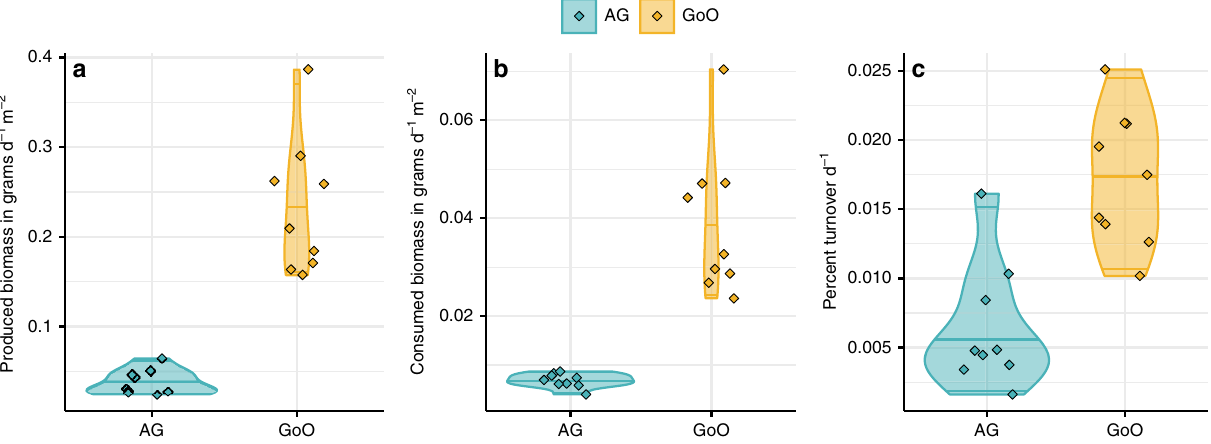
Fig. 6 Estimated biomass production, consumption, and turnover in cryptobenthic fi sh assemblages in the Arabian Gulf (AG) and Gulf of Oman (GoO). a Produced biomass (grams of fi sh tissue grown per day and m 2 ). b Consumed biomass (grams of fi sh tissue perished per day and m 2 ). c Percent turnover (renewal of produced and consumed biomass per day). Violin plots and lines represent medians and variance estimates (95% con fi dence intervals) for the three metrics across the two locations. Diamonds represent values for each sampled cryptobenthic reef fi sh community across the six